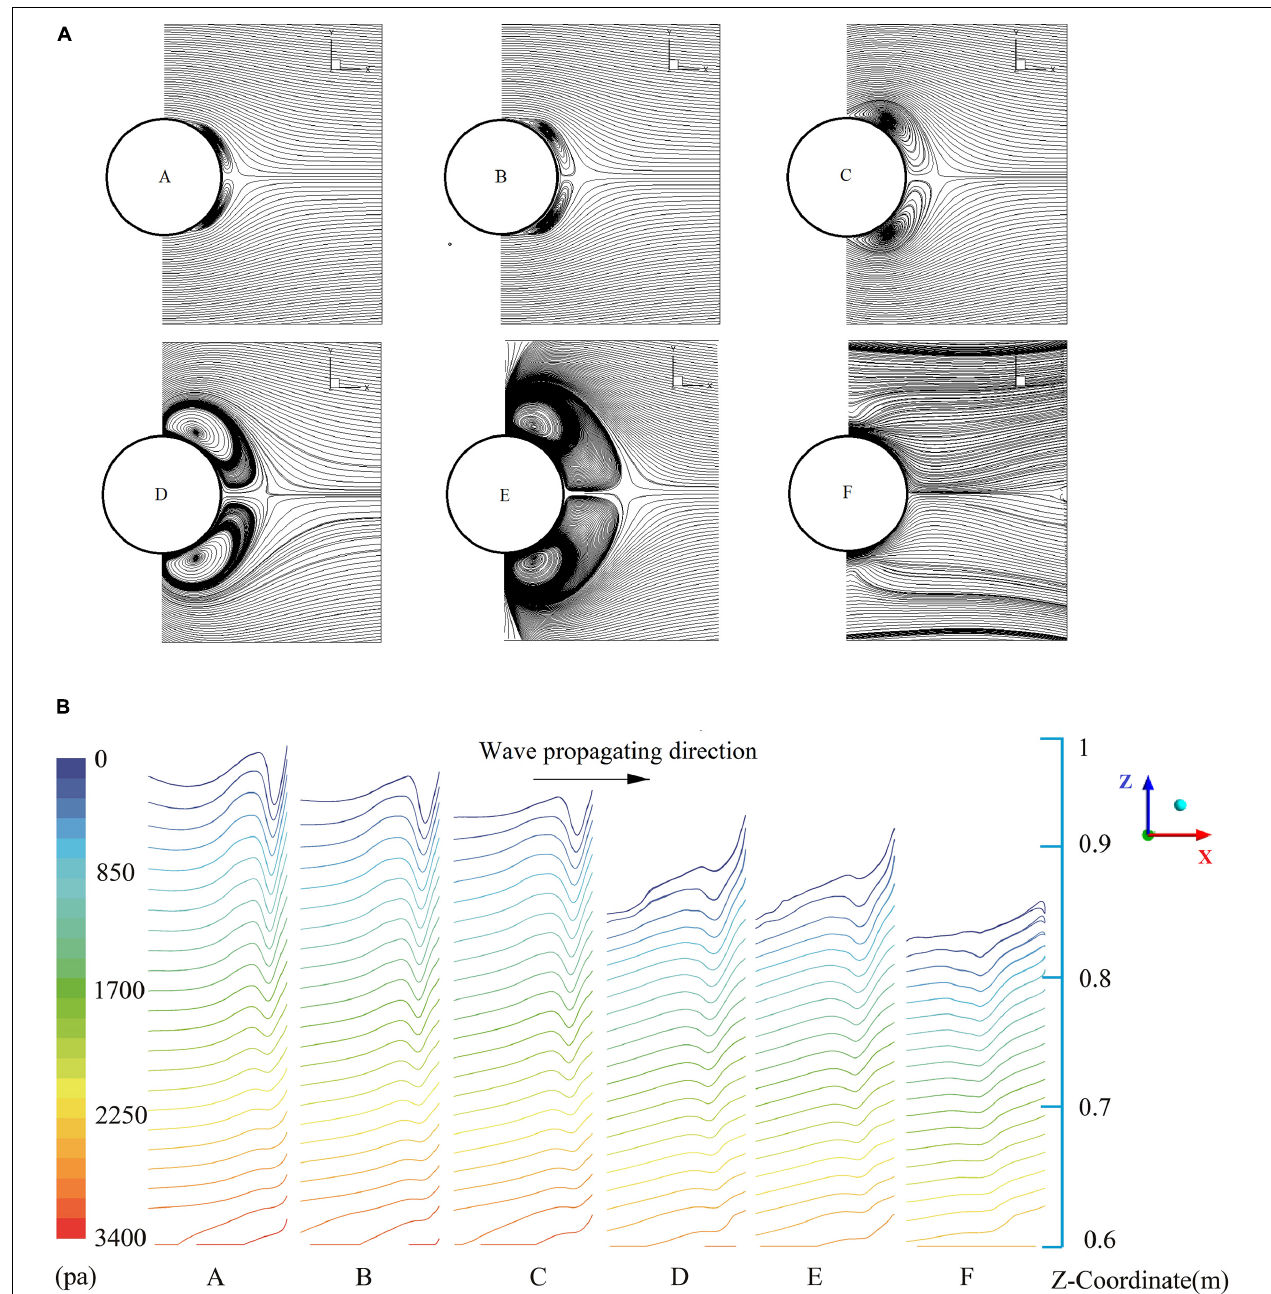
FIGURE 8 | Downstream vortices and side-wall pressure distribution during SLC. (A) downstream vortices, (B) pressure contour lines on the side-wall